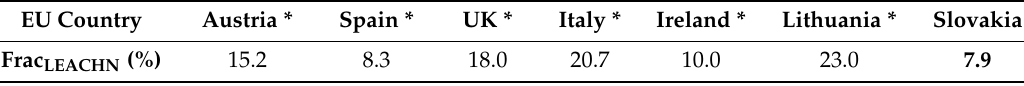
Table 6. Comparison of Frac LEACHN of selected EU countries published in 2017. EU